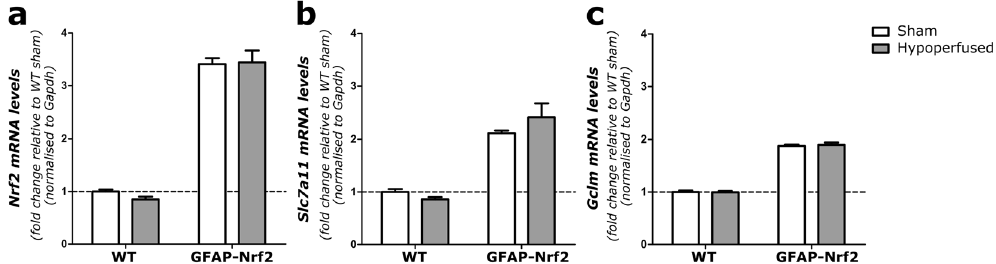
Figure 6. Nrf2, Slc7a11 and Gclm relative gene expression is higher in GFAP-Nrf2 animals with no effect of hypoperfusion. ( a ) Nrf2 , ( b ) Slc7a11 and (c) Gclm expression was significantly higher in GFAP-Nrf2 animals (F (1,32) = 298, p < 0.0001, F (1,32) = 74.05, p < 0.0001, F (1,32) = 737.5, p < 0.0001; respectively), but this was not altered by hypoperfusion. Gene expression was normalised to Gapdh and expressed relative to WT sham controls. Dashed line indicates average WT sham level. Mean ± SEM. Two-way ANOVA. n = 8–10 per